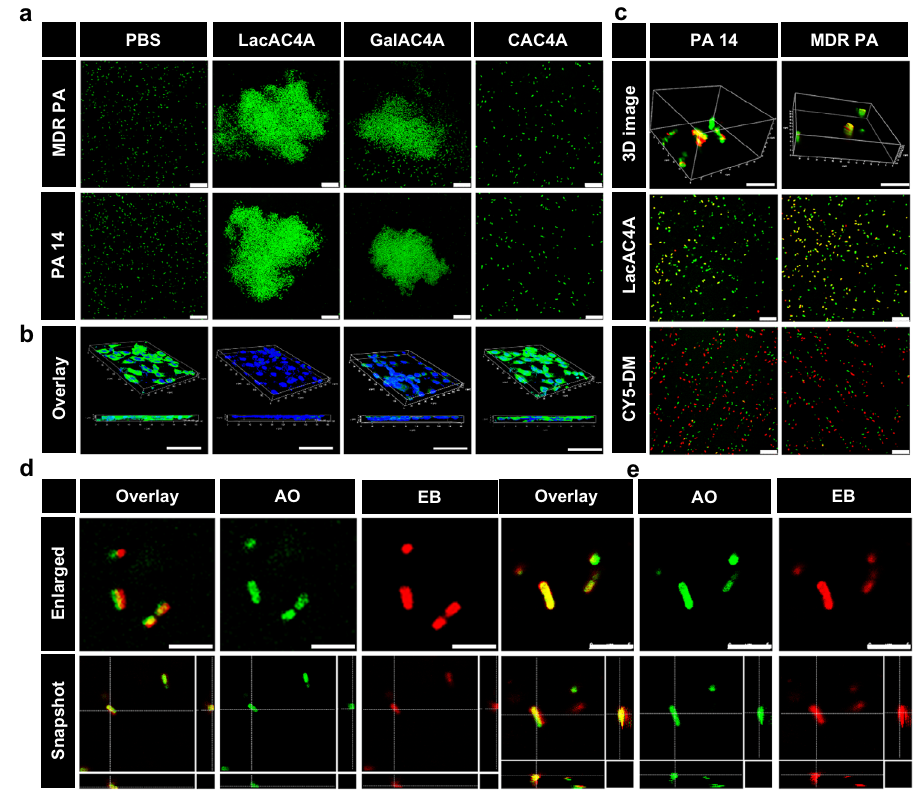
Fig. 3 | The bacterial recognition and internalization of LacAC4A. a CLSM images of the bacteria distribution after being treated with PBS, LacAC4A, GalAC4A,andCAC4A,respectively.Scalebarwas25 μ m. b CLSMimagesoftheNIH 3T3 cells infected by MDR PA after being treated by PBS, LacAC4A, GalAC4A, and CAC4A,respectively.Scalebarwas50 μ m. c CLSMimagesofLacAC4AandCY5-DM